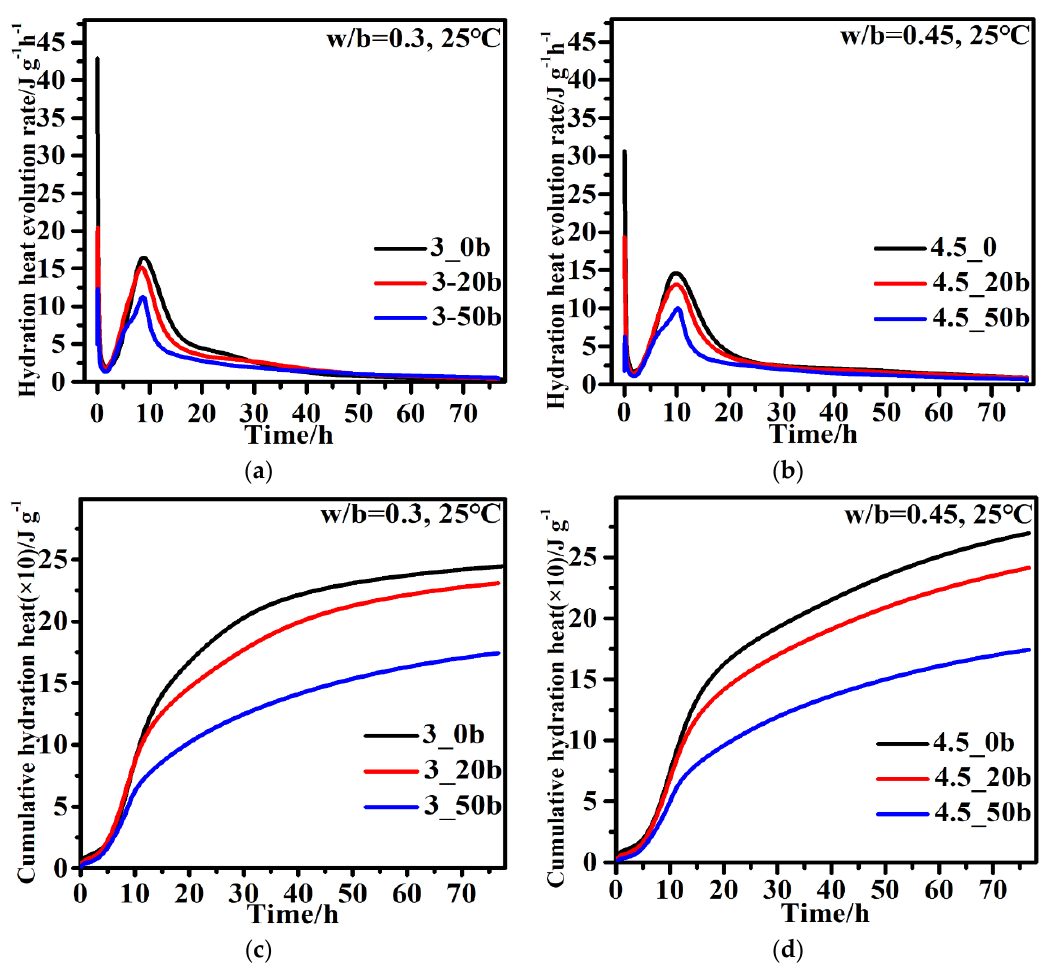
Figure 4. Hydration heat evolution rate: ( a ) w/b = 0.3, ( b ) w/b = 0.45; cumulative hydration heat: ( c ) w/b = 0.3, ( d ) w/b = 0.45.